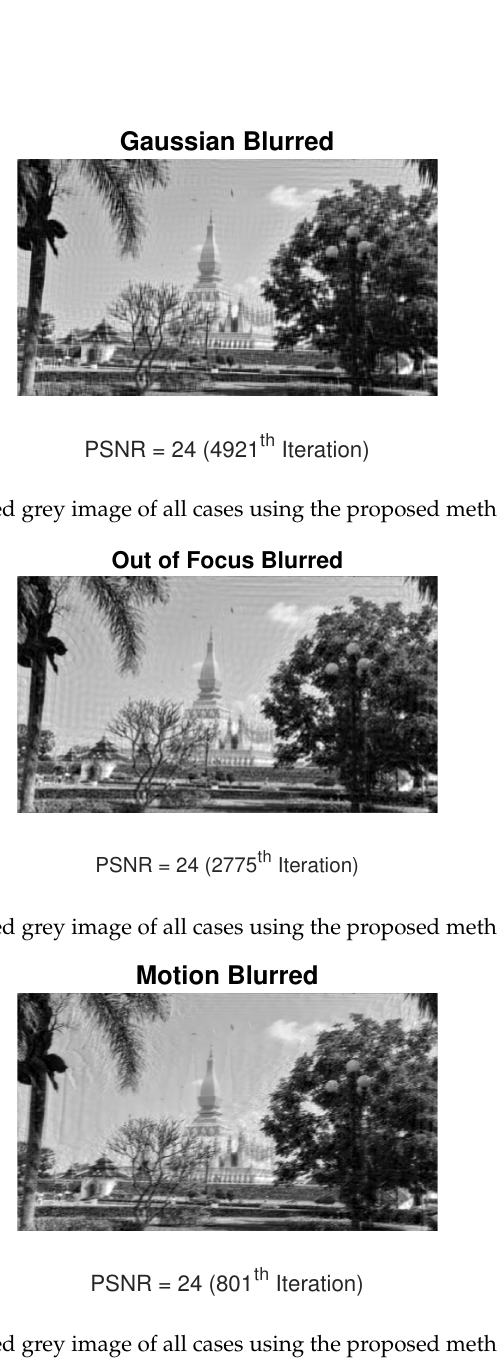
Figure 38. The reconstructed grey image of all cases using the proposed method (2) with PSNR = 24.